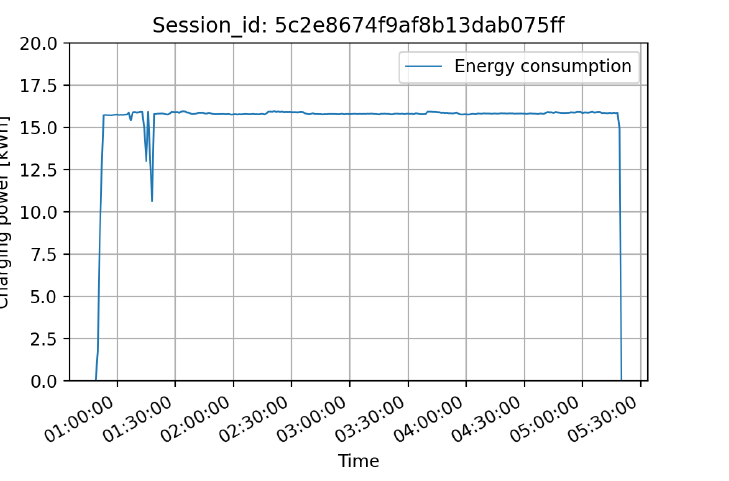
Figure 2. Charging curve of an electric vehicle on 7 November 2018 at the Caltech location.